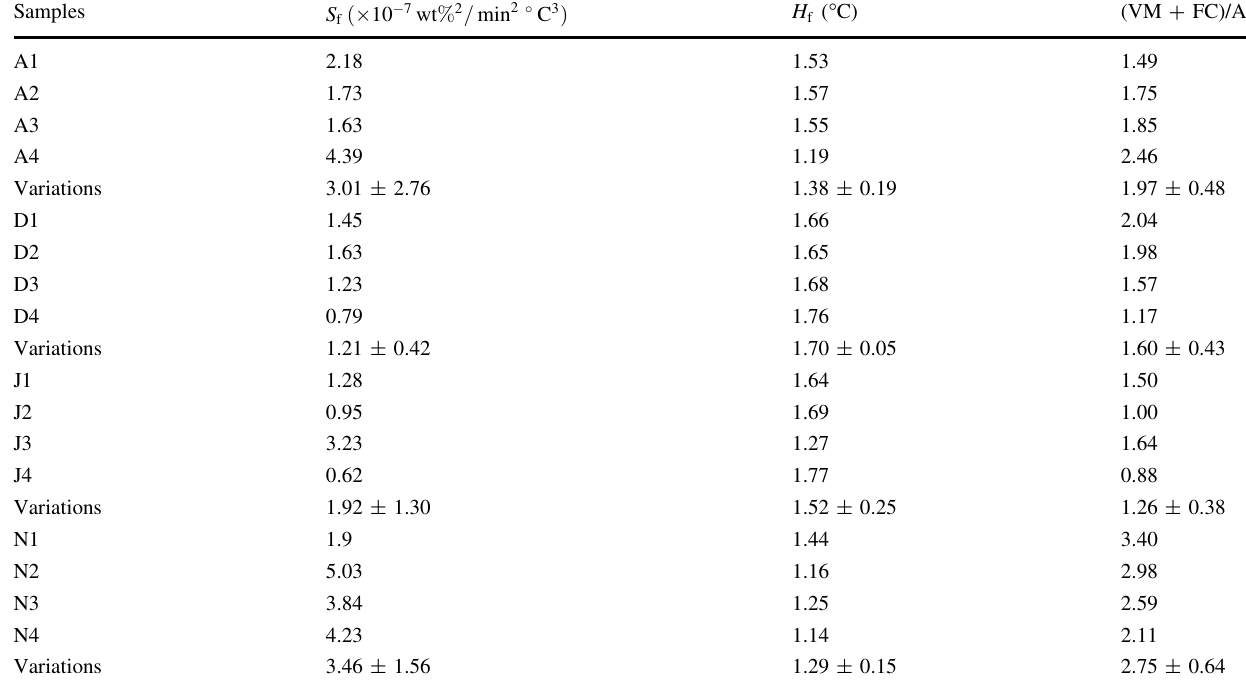
Table 4 Analysis of comprehensive indices and (VM ? FC)/A Samples